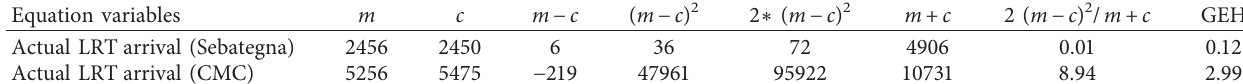
Table 1: Sebategna and CMC level crossing volume calibration results.